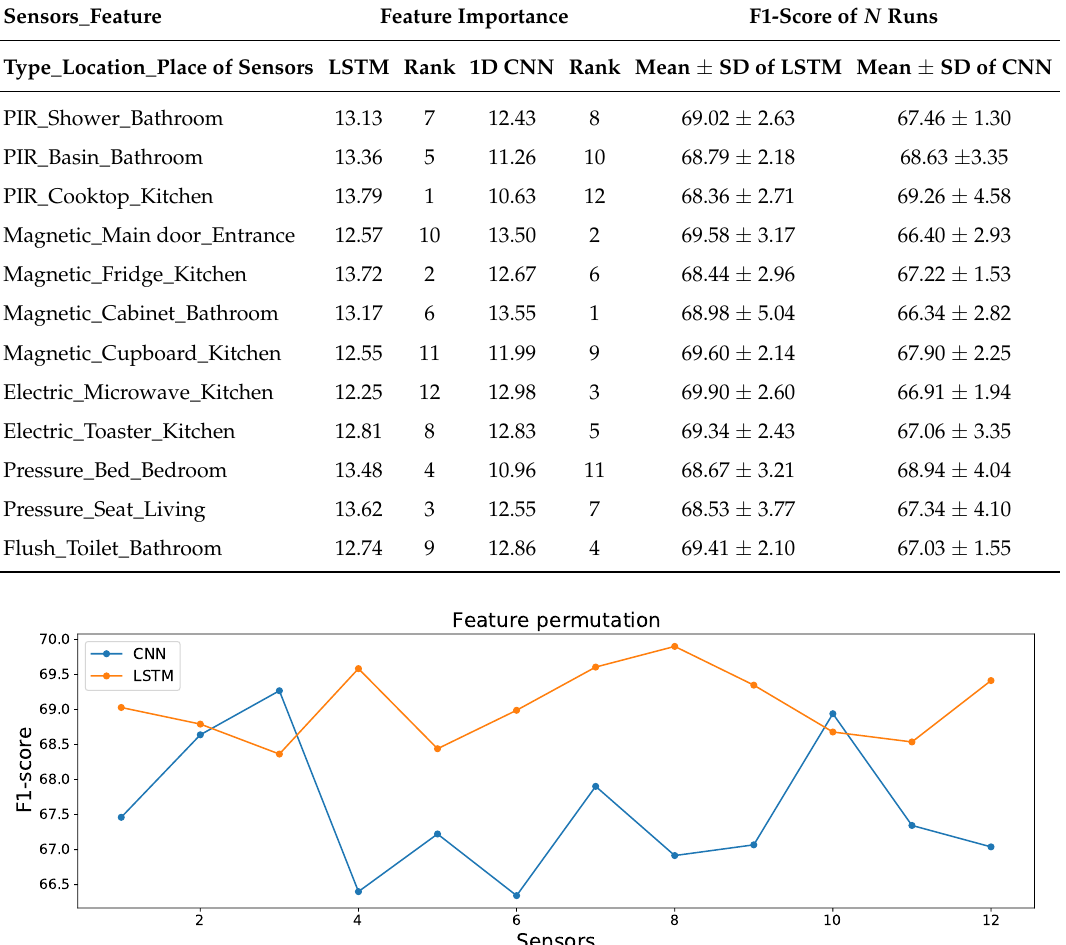
Table 7. Permutation feature importance of Ordonez Home A.